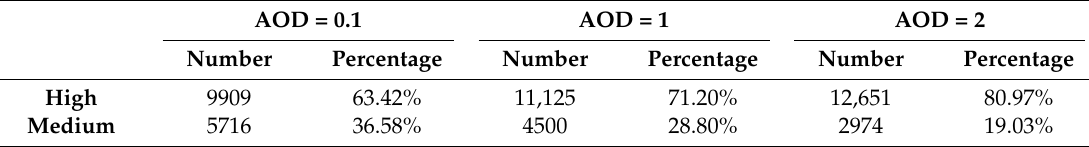
Table 3. EDR data quality statistics under three aerosol loading